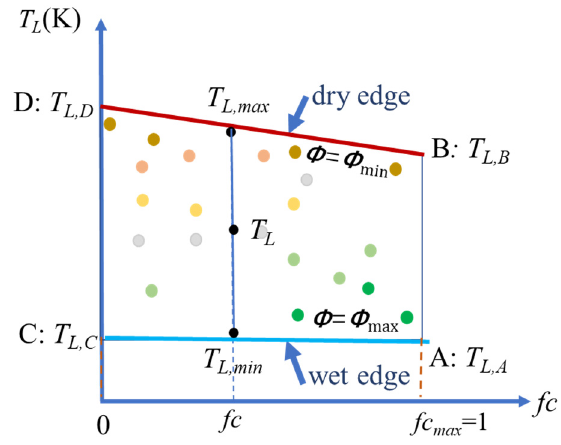
Figure 2. ABCD represents trapezoidal space framework. Colored circles represent pixels from satellite images with varying fc and T L . Points A and C represent conditions without water stress in full vegetation and bare soil, respectively. Points B and D represent conditions with extreme water stress in full vegetation and bare soil, respectively. Line AC and BD are the wet and dry edges in trapezoidal space, respectively.